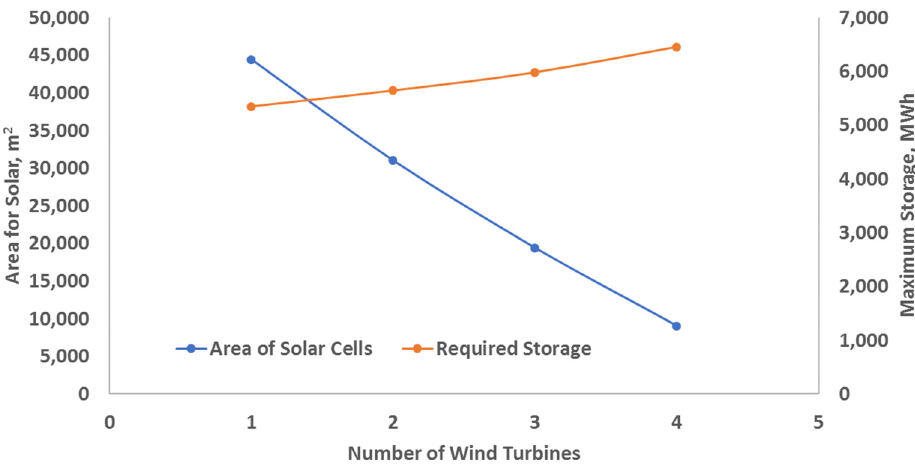
Figure 7. Effect of the number of wind turbines employed in the system on the area needed for PV cells and required storage capacity.